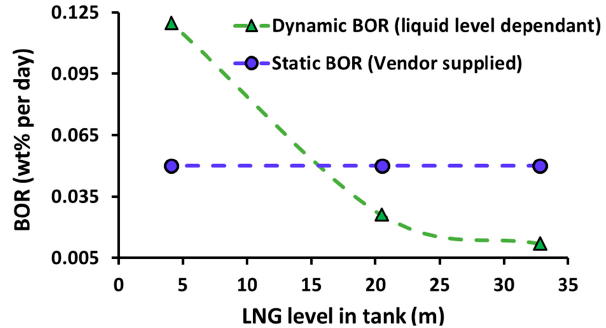
Figure 6. Static vs dynamic BOR in the tank.